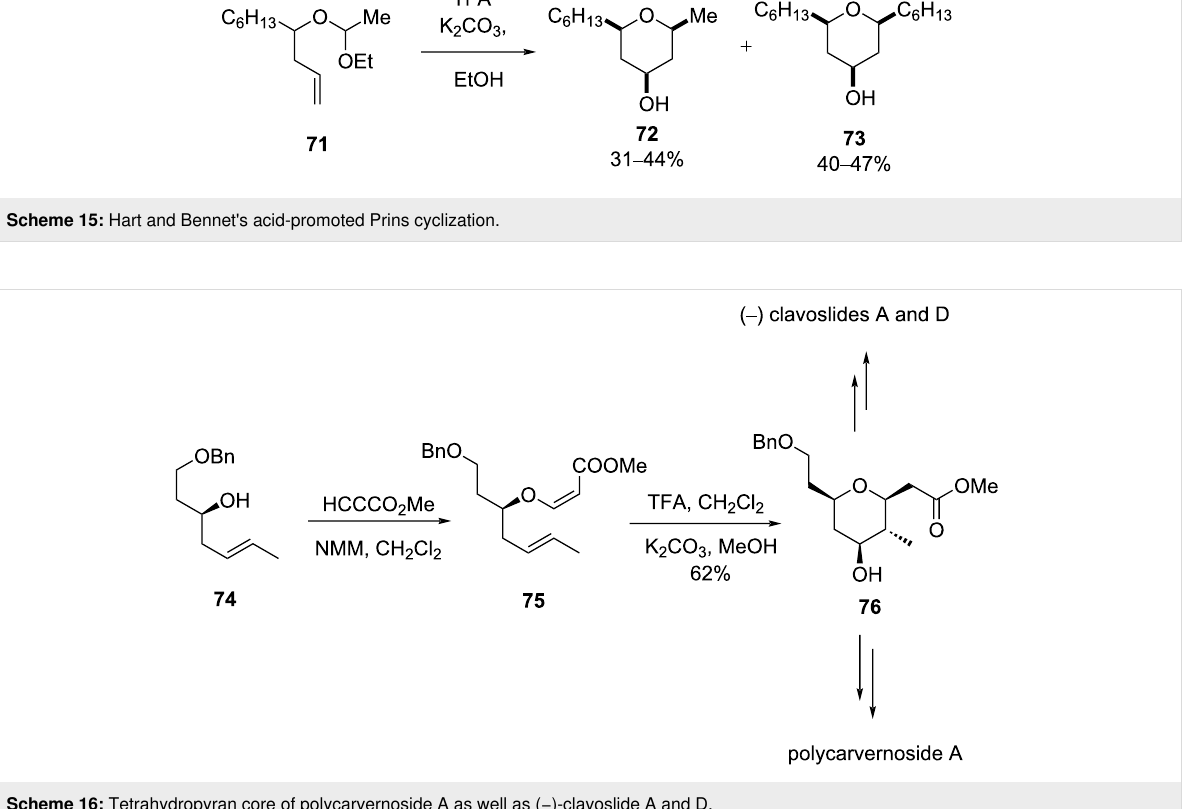
Scheme 16: Tetrahydropyran core of polycarvernoside A as well as ( − )-clavoslide A and